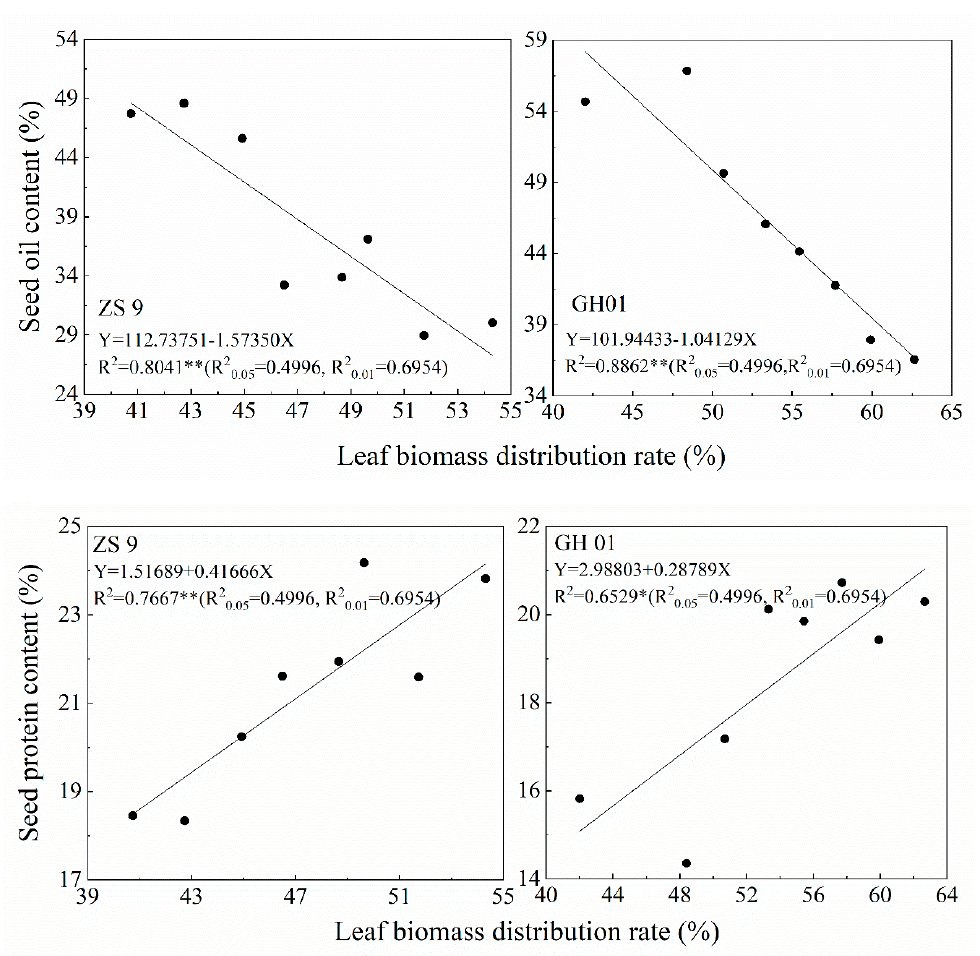
Figure 3. Correlation between seed oil content, protein content with leaf biomass distribution rate. * and ** significance at the 0.05 and 0.01 levels, respectively.